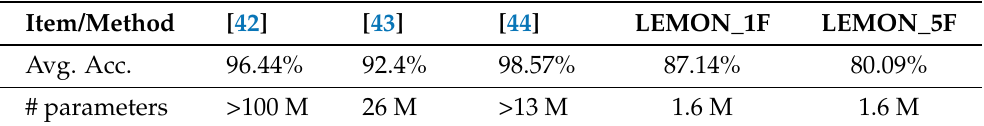
Table 9. Comparison of our approach, trained with one-fold and five-fold cross-validation, with respect to the state-of-the-art methods on the JAFFE Dataset in terms of average accuracy and number of parameters.